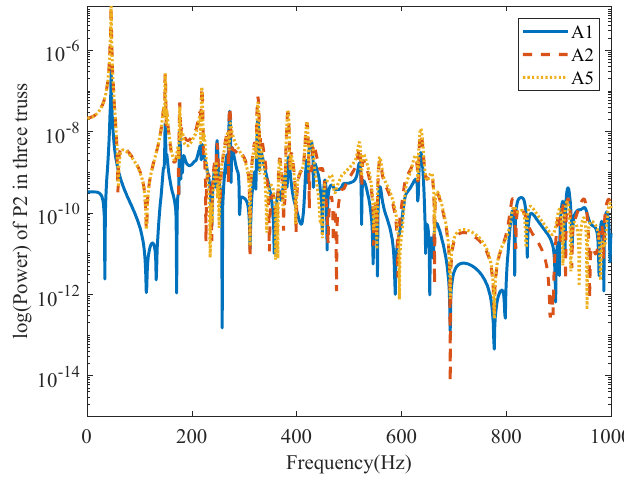
Figure 11. Vibration power flow of P2 in Y direction.